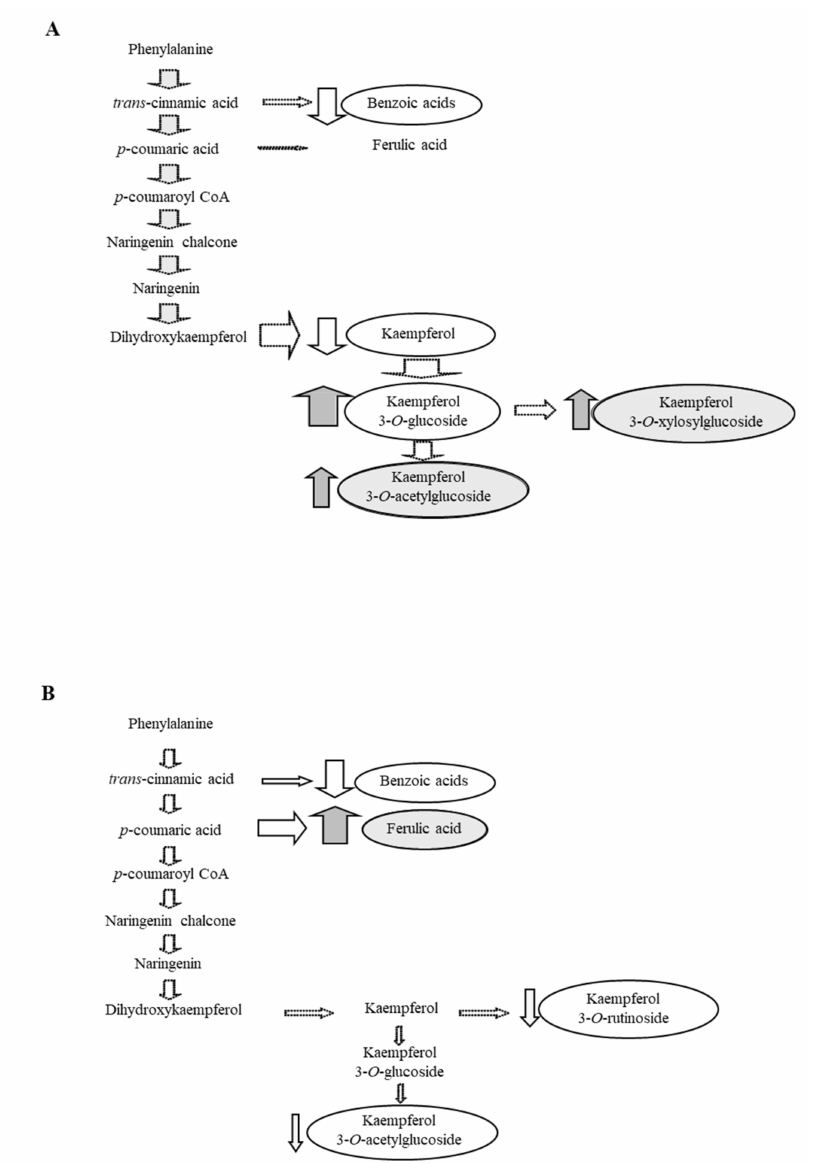
Figure 3. Simplified diagram showing polyphenol composition in relation to increasing altitude in the seed coat ( A ) and cotyledons ( B ). Only the constituents detectable in the respective seed fractions were illustrated in circles with the accompanying arrows indicating either an increased or decreased content with increasing altitude. The width of the arrow next to each component is a relative indication of the pool size with increasing